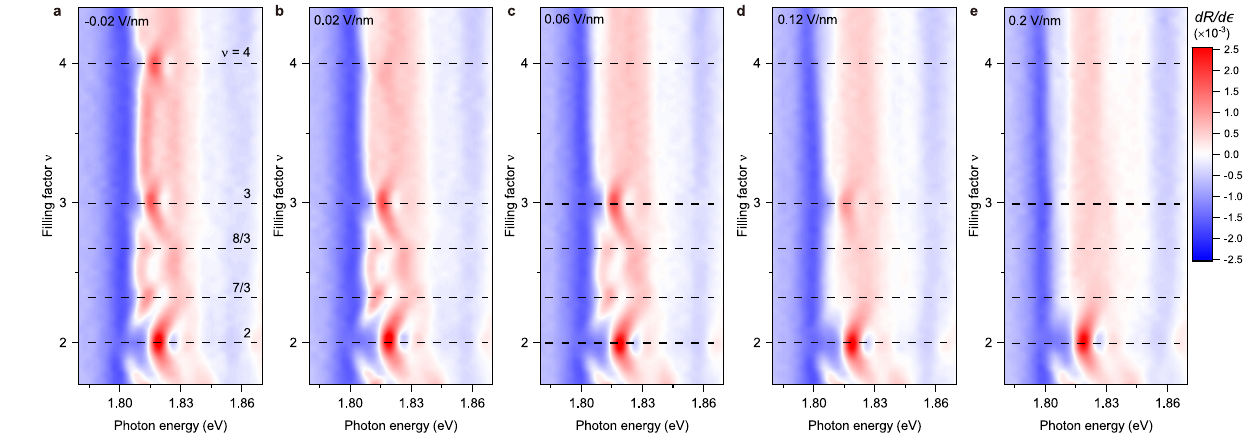
Fig. 2 | Electric- fi eld-tuned MITs. a – e The energy-derivative of the re fl ectance contrast spectrum ( dR = d ϵ ) of the sensor 2sexcitonas a functionof electron fi lling factor ( ν =2 – 4) under out-of-plane electric fi eld of − 0.02V/nm ( a ), 0.02V/nm ( b ),